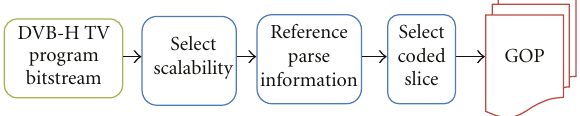
Figure 9: GOP Divide Workflow.